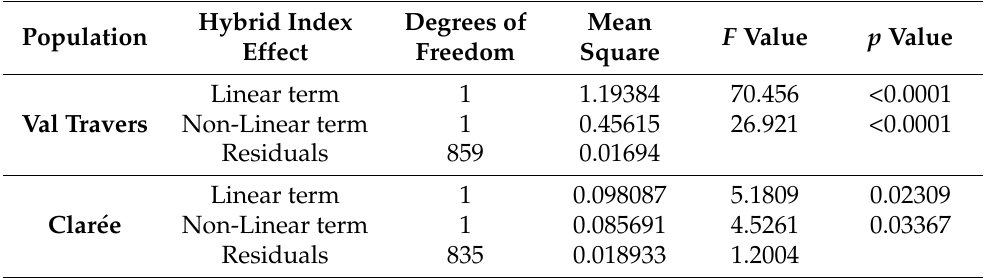
Table 4. ANOVA analysis of the linear models testing for the linear and non-linear effects of Hybrid Index on individual Homozygosity Level in Val Travers and Clar é e